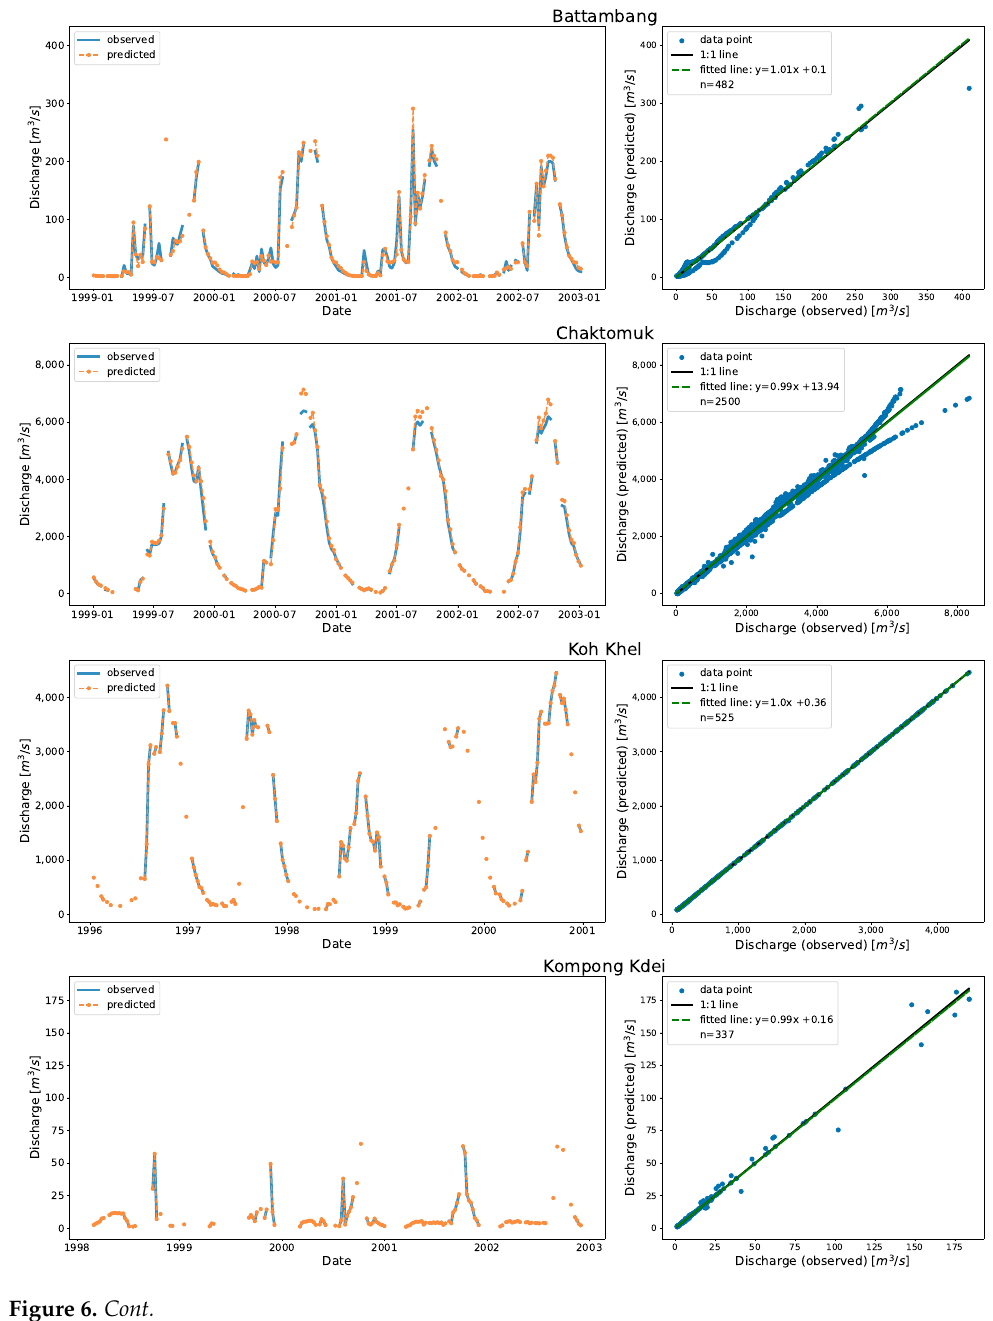
data point 1:1 line fitted line: y=1.01x +0.1